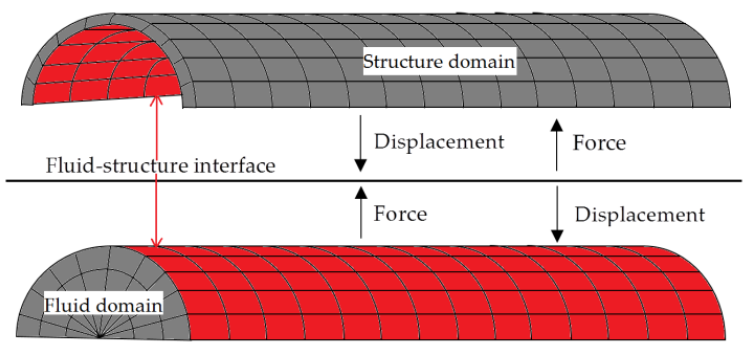
Figure 1. Transitive relation at fluid – structure interface.